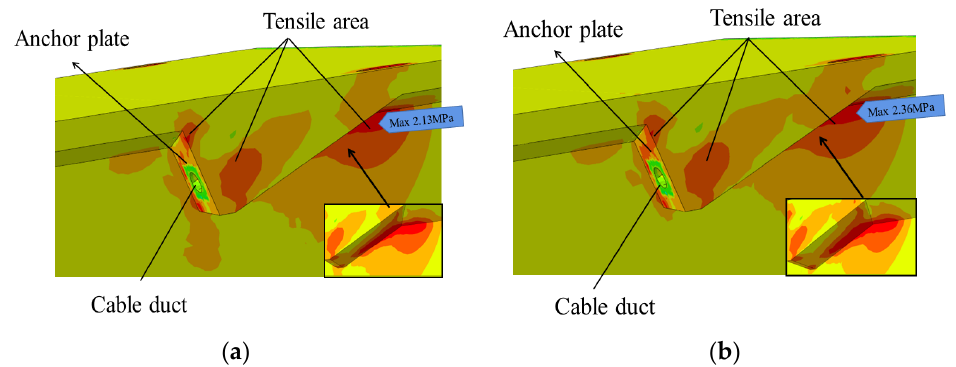
Figure 13. Stress cloud diagram of anchorage zone. ( a ) A1 cable fracture situation; ( b ) A8 cable fracture situation.